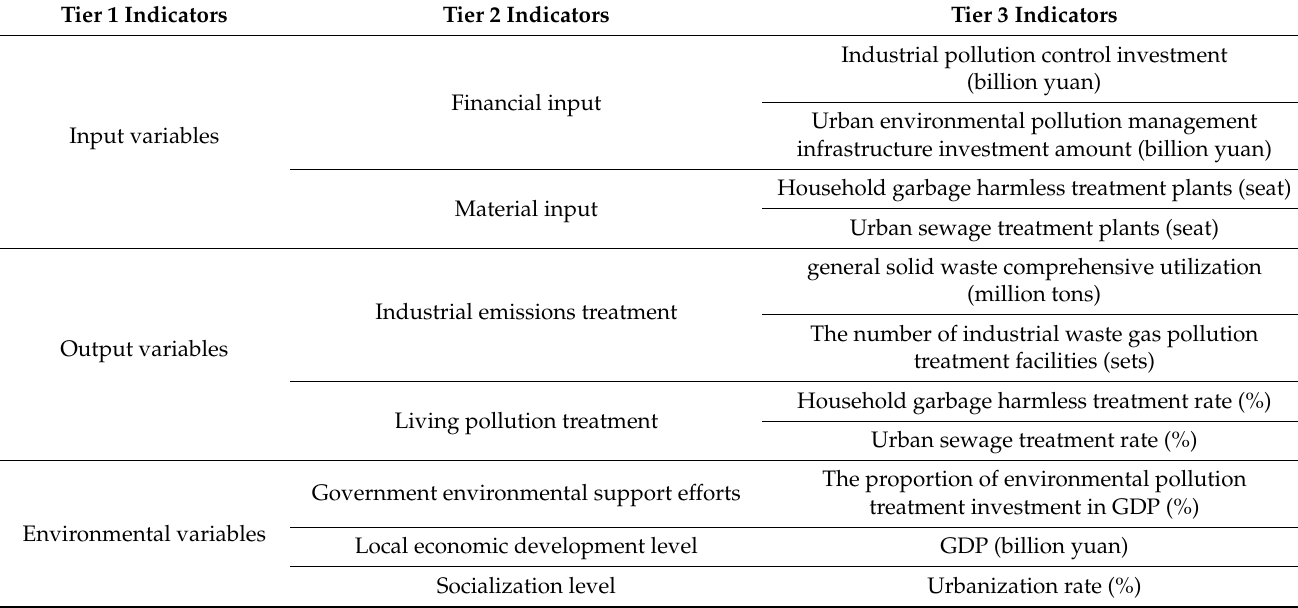
Table 1. Investment efficiency indicators of environmental